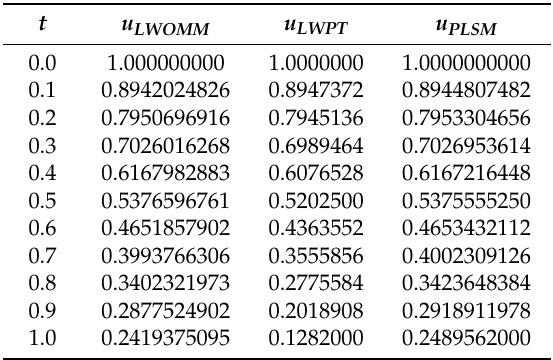
α= obtained by the introduced method, the